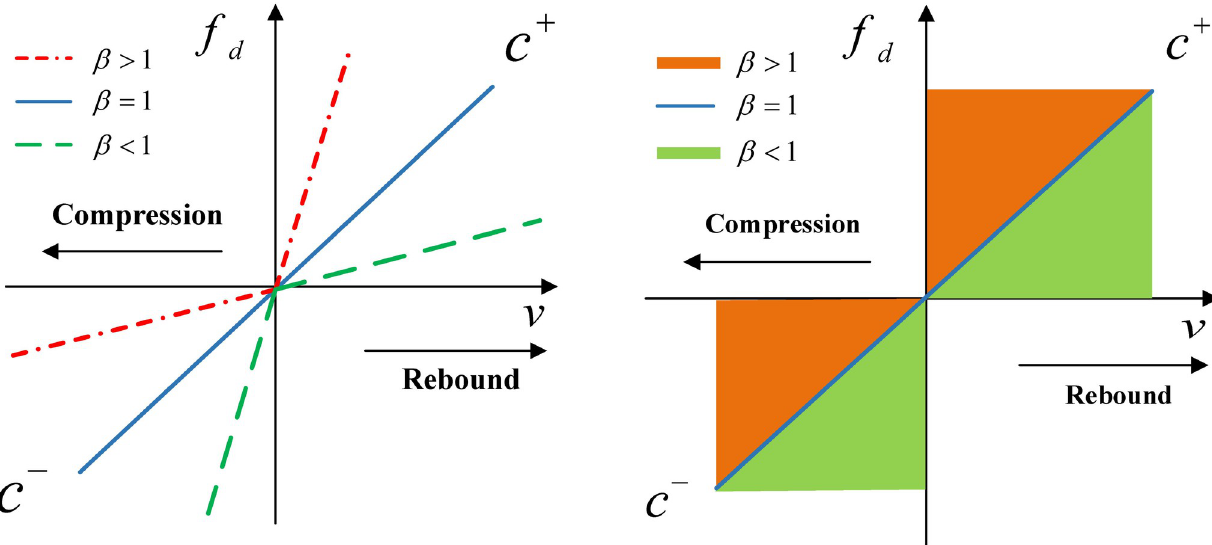
Fig 2. Damping force-velocity characteristic curves. (A) Passive suspension damper; (B) Damping-adjustable damper.